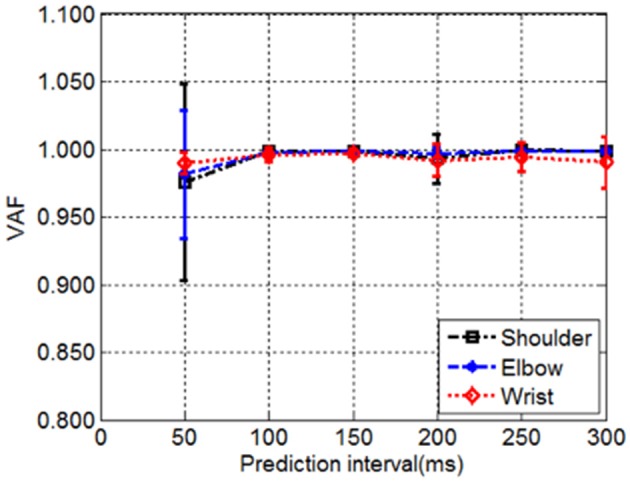
The decoding performance demonstrated by the VAF as a function of prediction interval. The VAF between measured and decoded shoulder, elbow and wrist joint angles over the tested prediction intervals were averaged across all subjects. The vertical bars gave the corresponding standard deviations.